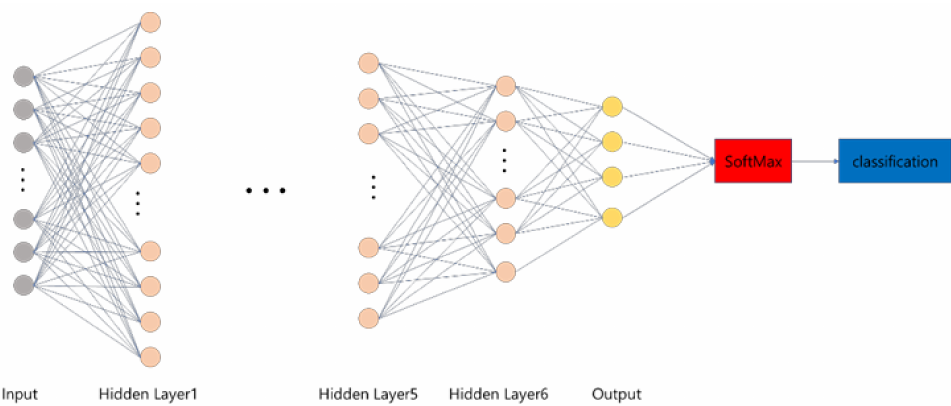
Figure 11. Proposed Neural Network